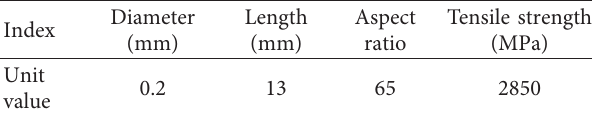
Table 7: Physical properties of steel